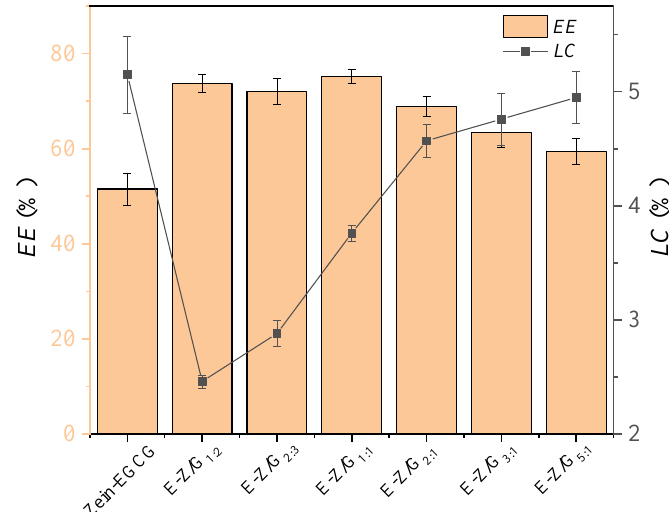
Figure 2. The EE and LC values of different samples.